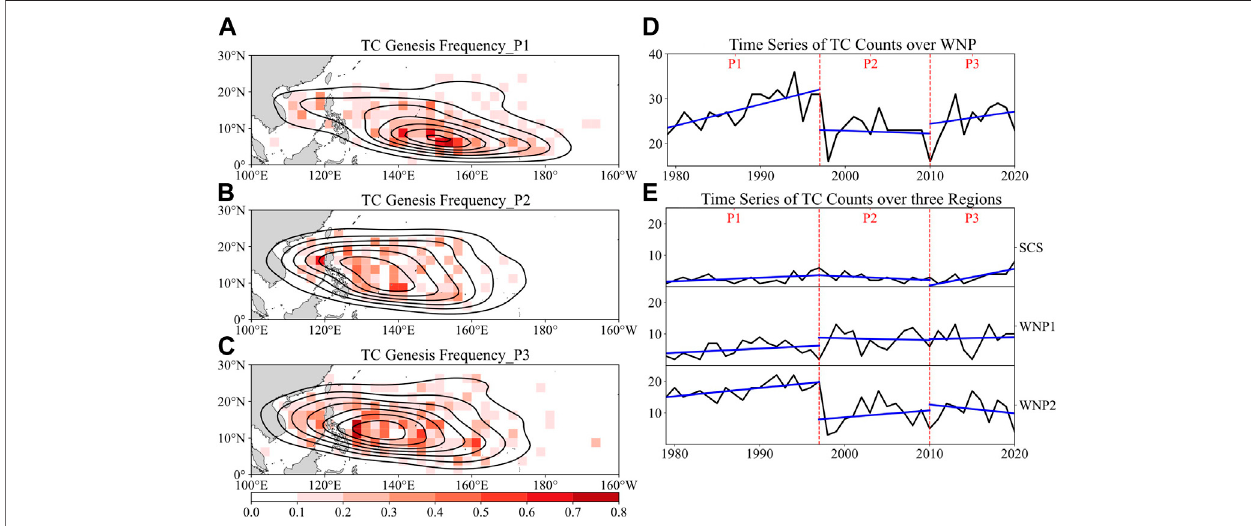
FIGURE 7 | (A – C) are the TC genesis frequency in the three periods, the contours are the KDE of genesis location, and the colour is the genesis frequency in one grid; (D) isthetimeseriesofTCgenesiscountsduring1979 – 2020,theblacklinereferstothecountfromtheIBTrACsdataset, andthebluelinesarethetrendlinesofTC countchangeinP1,P2,andP3.Thereddashedlinesreferto1997and2010toseparateP1,P2,andP3; (E) issimilarto (D) ,butforthetimeseriesofTCgenesiscounts in SCS, WNP1, and WNP2.